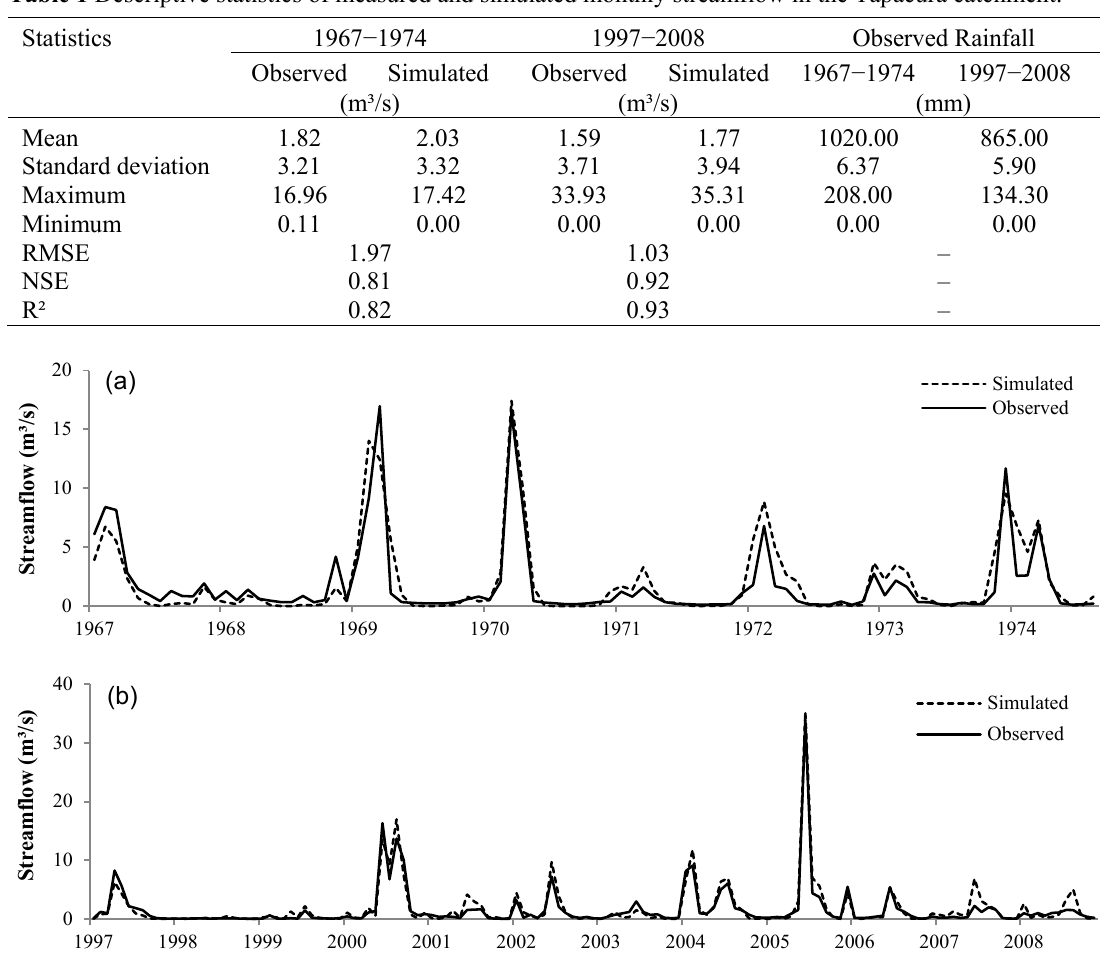
Fig. 2 Simulated versus observed monthly streamflow in the Tapacurá catchment: (a) calibration for period 1967−1974, and (b) calibration for period